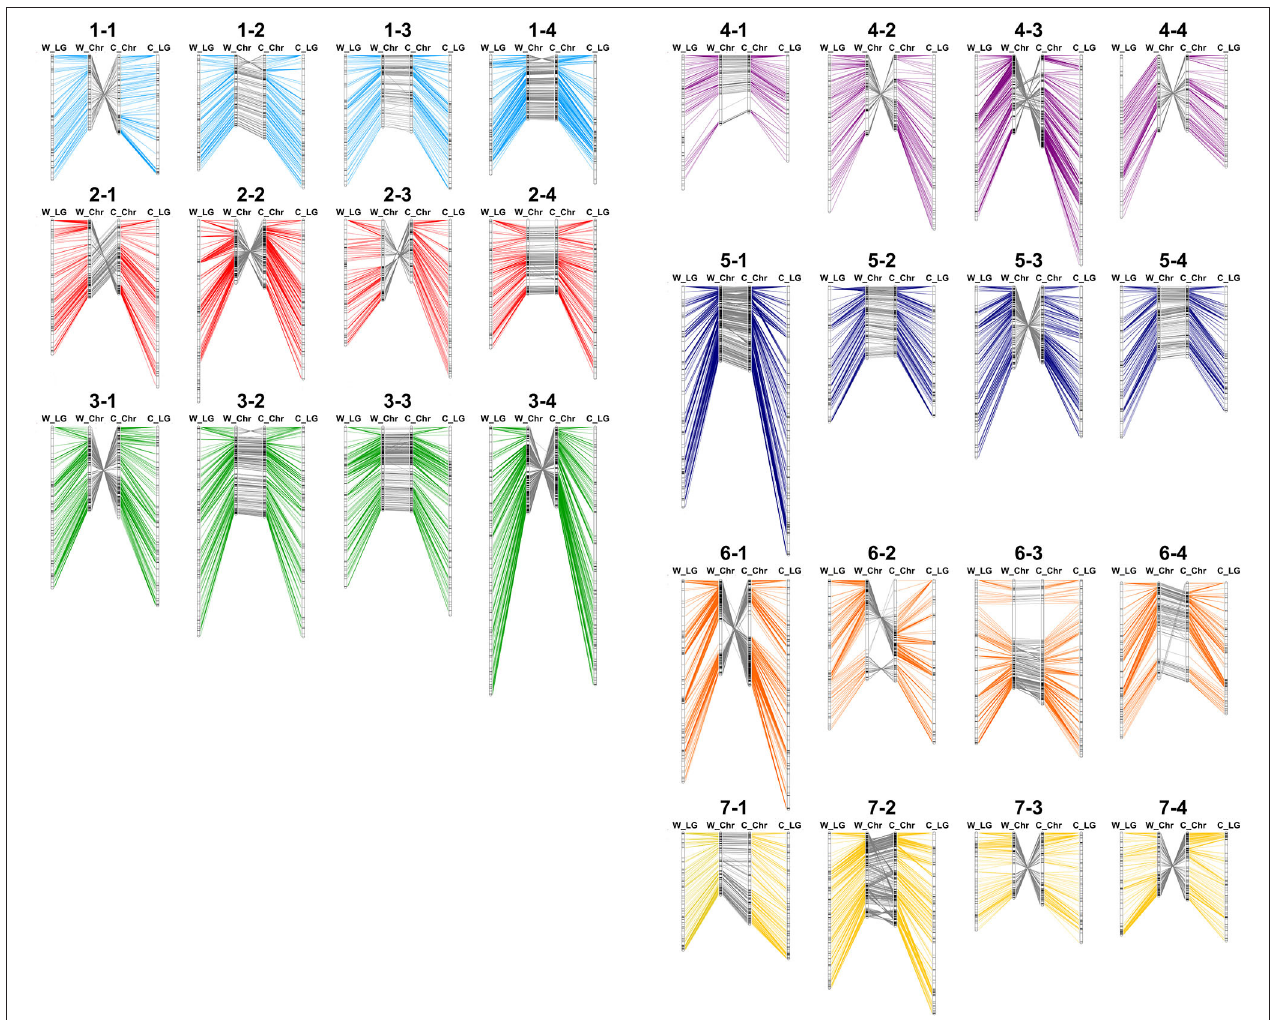
FIGURE 2 | Comparison of physical and genetic position of markers in ‘Wongyo 3115’ and ‘Camarosa’ genomes. W_LG, the linkage group of ‘Wongyo 3115’; W_Chr, chromosome of ‘Wongyo 3115’; C_Chr, chromosome of ‘Camarosa’; C_LG; the linkage group of ‘Camarosa’.